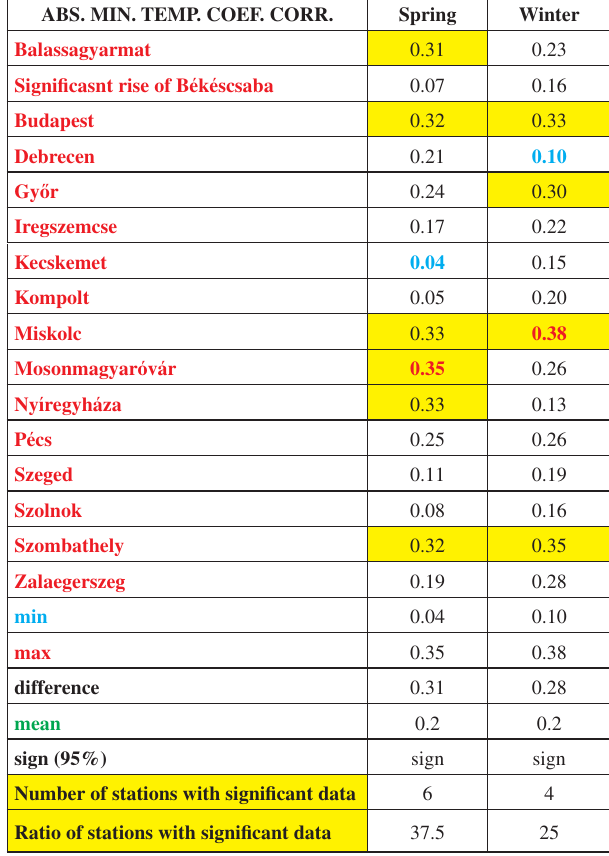
Table 2 – Values of the slope of the linear trendfunction regarding the absolute minimum temperatures measured at 16 stations in spring and in winter (1951–2010) Slope ABS. MIN.TEMP.